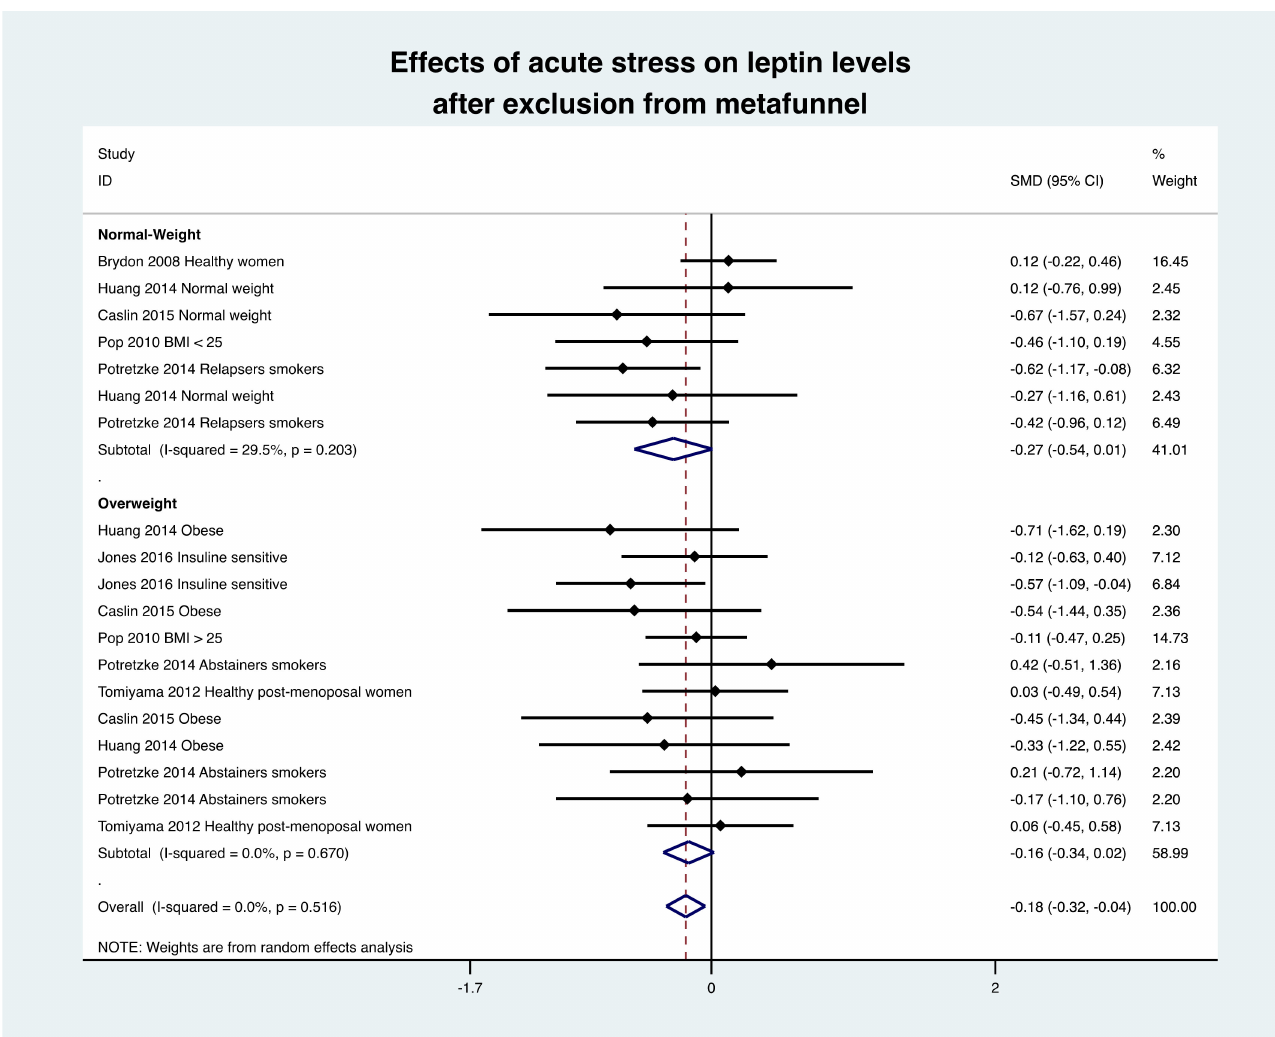
Figure A1. Meta-analysis of leptin levels after an acute stress compared to baseline levels after exclusion of studies outside of the